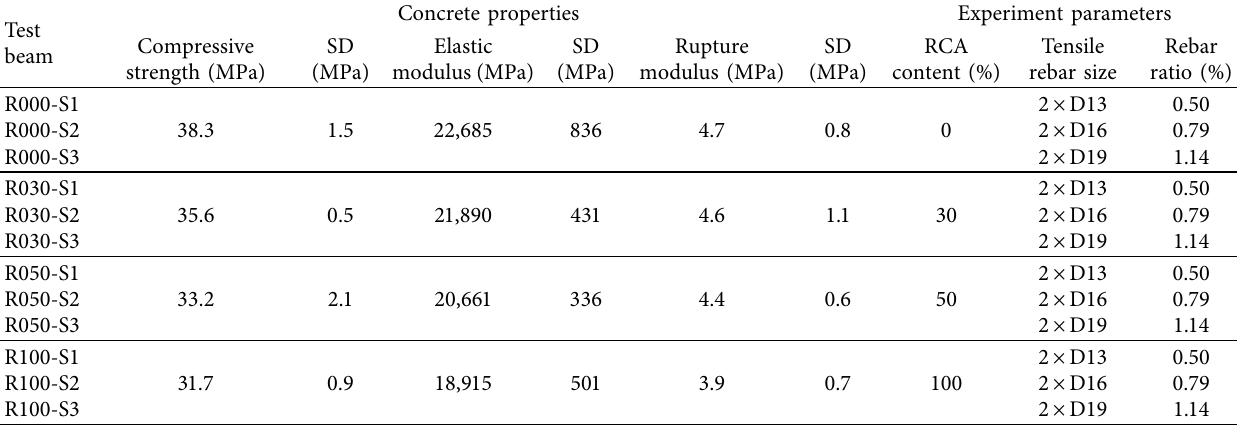
Table 3: Concrete properties and experimental parameters of the test